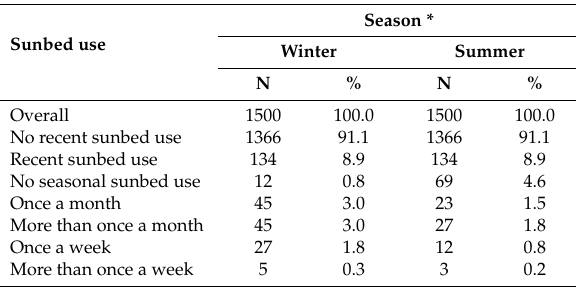
Table 1. Seasonal one-year prevalence of sunbed use.